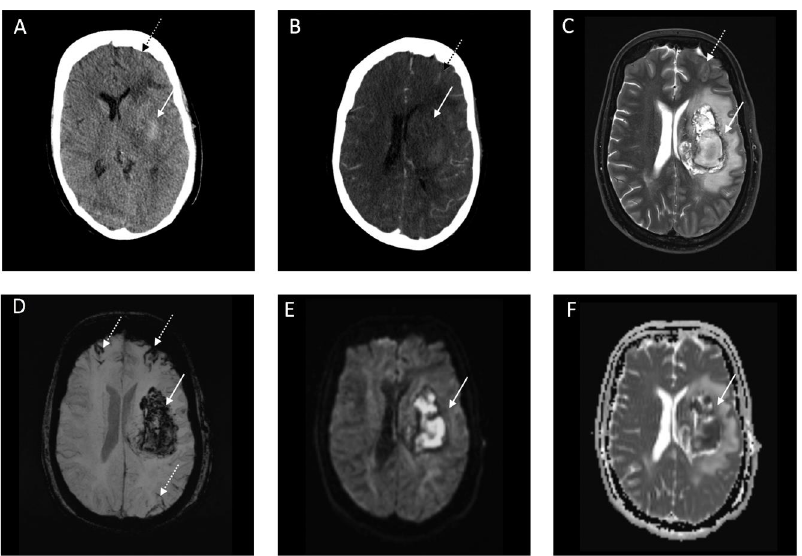
Figure 3. Representative computed tomography (CT) and Magnetic Resonance Imaging (MRI) images of a patient with Coronavirus Disease 2019 with a deep parenchymal hemorrhage and subarachnoid hemorrhage (SAH). Legend: ( A ): Brain CT image with corresponding computed tomography (CTA) image indicative of no underlying vascular pathology ( B ) at admission. ( C – F) : Brain MRI image one day after hospitalization with T2w ( C ), susceptibility weighted imaging (SWI) ( D ), diffusion weighted imaging (DWI) ( E ), and corresponding apparent diffusion coefficient (ADC) imaging map ( F ). White arrow indicates acute intracerebral hemorrhage. White-black dotted arrow indicates acute SAH. J. Clin. Med. 2019 , 8 , x FOR PEER REVIEW